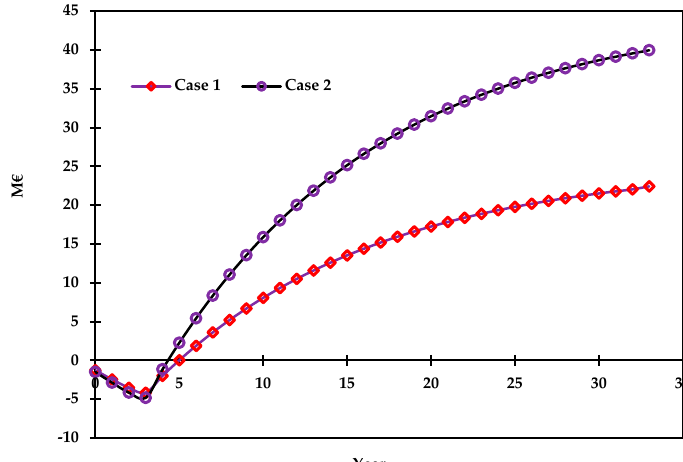
Figure 7. Cash flow diagram for case 1 and case 2.